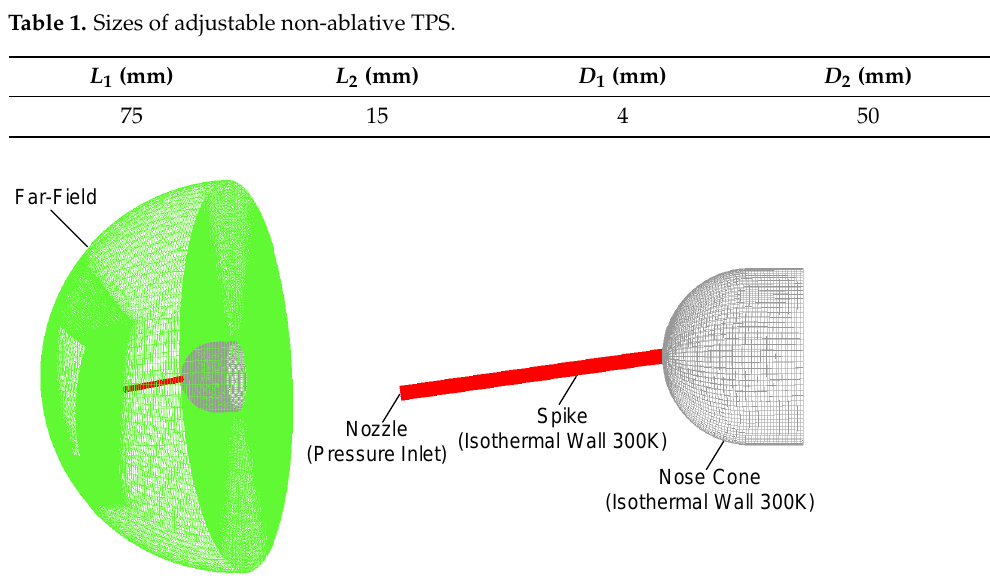
Figure 2. Computational grid. Table 2. Jet and far-field conditions.